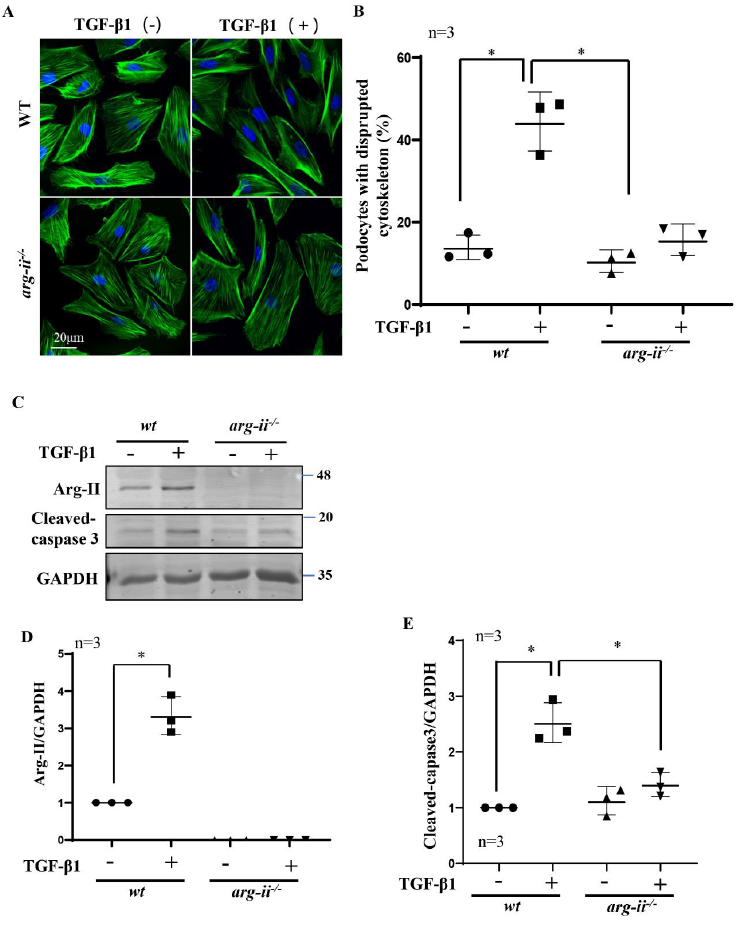
Figure 5. Arg-ii knockout in podocytes prevents TGF- β 1-induced podocyte cytoskeleton disorganization and apoptosis. Podocytes were treated with or without TGF- β 1 (10 ng/mL) for 48 h and subjected then to ( A ) phalloidin staining of cytoskeletal actin fibers (green). The nucleus were stained with DAPI (blue). ( B ) Quantification of podocytes with disrupted actin cytoskeleton is presented in the graph. ( C ) Immunoblotting analysis of the protein levels of Arg-II and cleaved-caspase 3 in dif- ferent groups of podocytes as indicated; GAPDH serves as the loading control. ( D , E ) Graphs show- ing quantification of the signals of Arg-II and cleaved-caspase 3, respectively. * p < 0.05 between the indicated groups. n = 3.